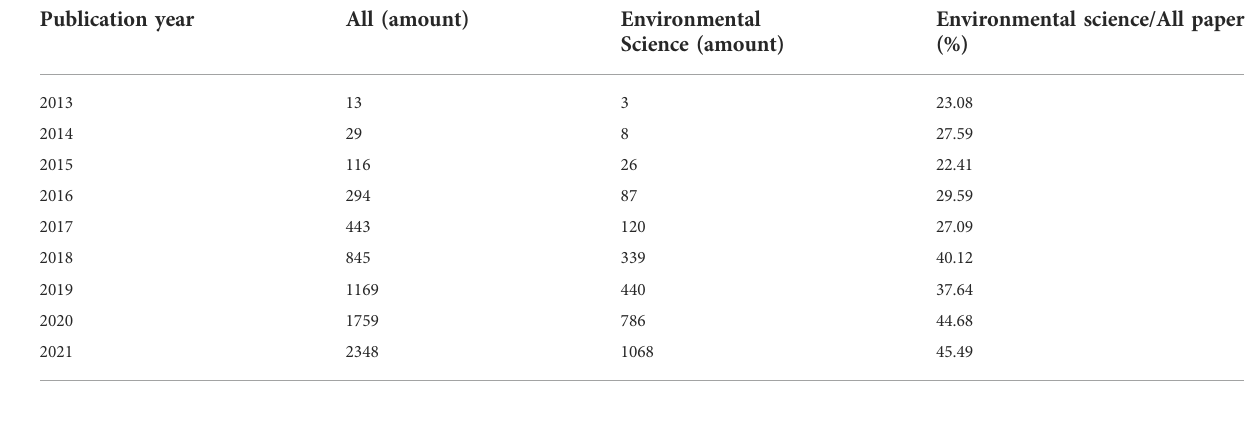
TABLE 1 A summary publication on the SDGs from 2013 to 2021, based on Scopus.